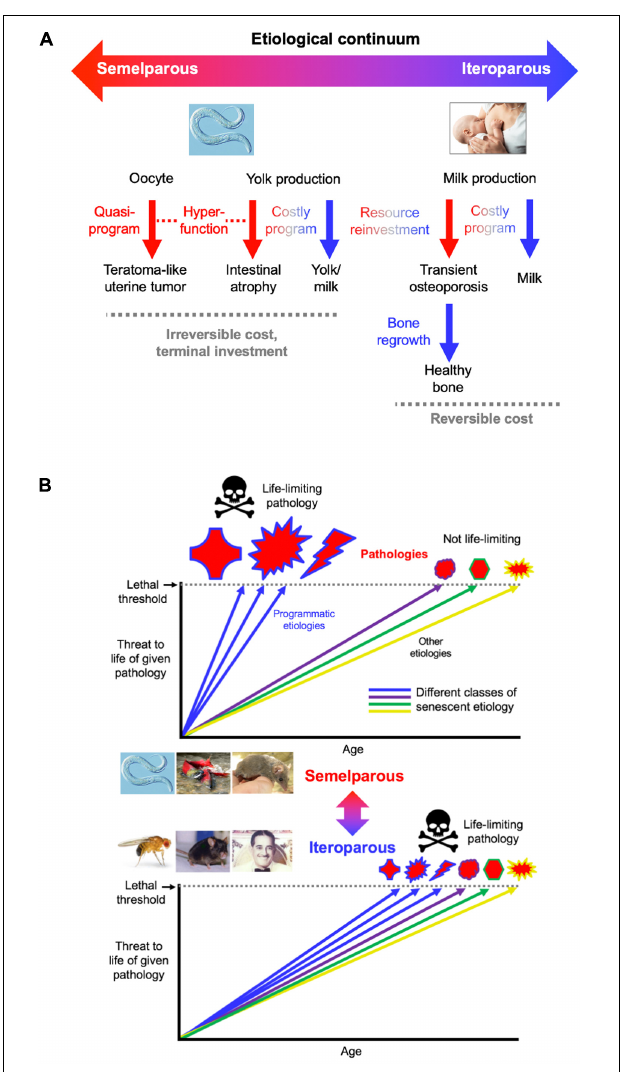
FIGURE 7 | Conceptual models of aging in semelparous and iteroparous organisms. (A) Programmatic mechanisms of aging in semelparous and iteroparous organisms. These include costly programs and quasi-programs. A broad prediction is that costly programs contribute more to disease during reproductive death, and quasi-programs more in iteroparous aging. (B) Difference in senescent pathogenesis in semelparous and iteroparous organisms. The figure shows the degree of harmfulness of a range of pathologies with different types of etiology (indicated by different colors). Top, reproductive death. Here exaggeration of programmatic mechanisms leads to rapid development of gross pathologies leading to death. Bottom, typical animal senescence (iteroparous species). Here many more types of etiology contribute to life-limiting pathology, to which programmatic etiologies contribute to some degree, and senescence is more multifactorial. Preventing programmatic pathophysiology that causes reproductive death causes very large increases in lifespan, giving a false impression that the entire aging process has been suppressed. All images reproduced with